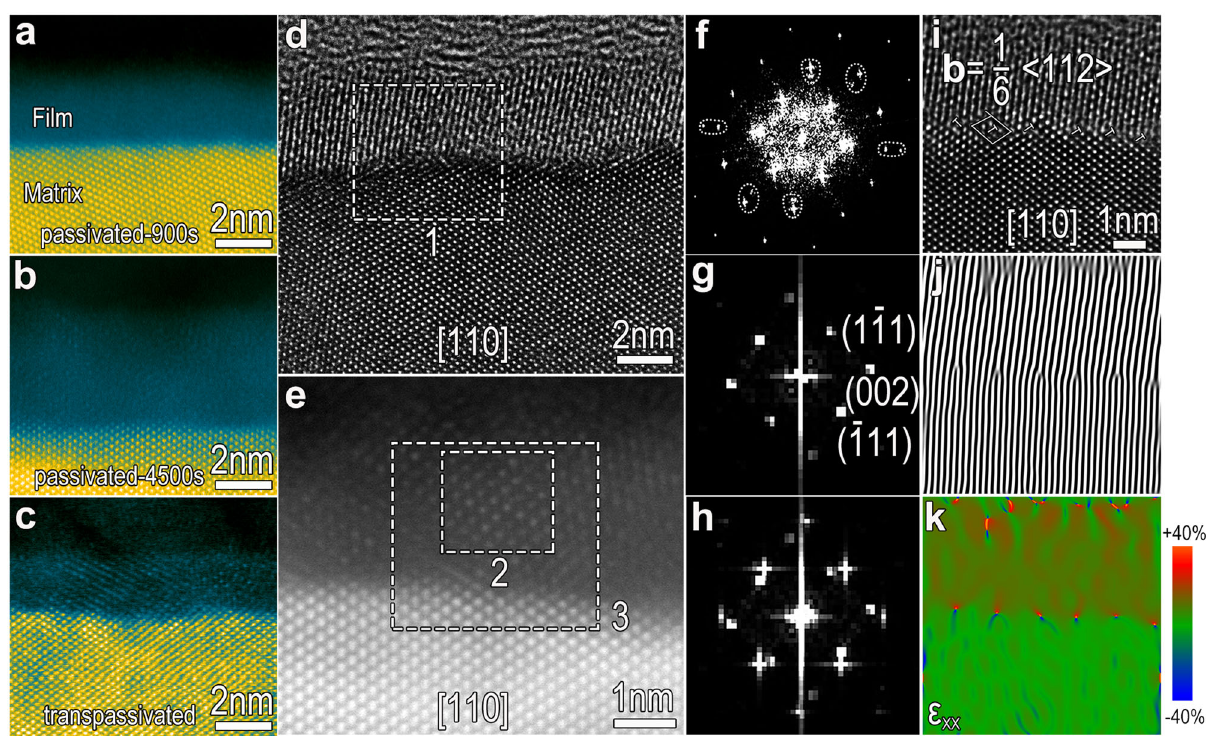
Fig. 5 Transpassivation-induced modi fi cations of the passive fi lm. a – c Transpassivation-induced crystallinity on the surface fi lm. High-resolution HAADF-STEM images along the [110] axis of the austenitic matrix showing the passive fi lms anodically formed in 0.5 mol L − 1 H 2 SO 4 electrolyte ( a , b ) are almost amorphous with some crystalline constituents, whereas the transpassive fi lm ( c ) is highly crystalline. The atomic columns in the transpassive fi lm are distinct. d – h Highly-crystalline transpassive fi lm grows epitaxially on the single-crystal matrix. HRTEM image ( d ) and high-resolution HAADF-STEM image ( e ), along the [110] axis of the austenitic matrix, showing the distinct lattice fringes and atom columns in the transpassive fi lms. Fast Fourier transform (FFT) images corresponding to region 1, including the fi lm and matrix ( f ), region 2 including transpassive fi lm ( g ), and region 3 ( h ) illustrate that both phases have a well-de fi ned epitaxial orientation relationship. The lattice parameter of the fcc-structured transpassive fi lm is determined to be 0.43 nm, which is a mis fi t for the FeCr15Ni15 austenitic matrix with a lattice parameter of 0.36 nm. i HRTEM image taken along the [110] matrix direction showing a large number of mis fi t dislocations with Burgers vector of b = 1/6 < 112> at the interface of metal/transpassive fi lm (Me/TF). j IFFT (Inverse fast Fourier transform) image of i based on the (002) plane showing a periodic array of dislocations along the interface. k Geometric phase analysis (GPA) on the Me/TF interface shows enormous strain at the dislocation